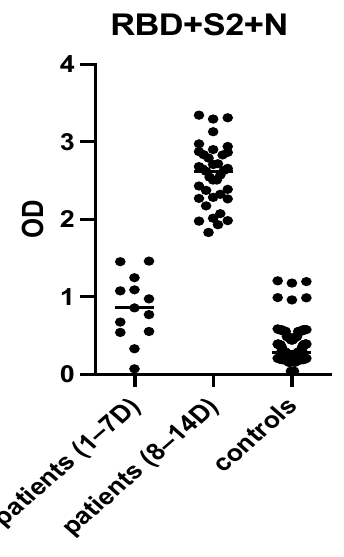
Figure 4. Immunoreactivity of the most potent combination of protein antigens among patients’ and controls’ sera (at a dilution of 1:100) using the “in-house” ELISA, where the combination of 3 different proteins (RBD 2.5μg/mL, S2 1μg/mL, N 1.5μg/mL) was used as the capture antigen. Patients’ sera were divided in two groups obtained 1–7 days and 8–14 days after disease onset. The cut-off value for each antigen was determined using the mean optical density plus 2 SDs of controls. Black symbols represent the Optical Density (OD) value of each serum at 405 nm.